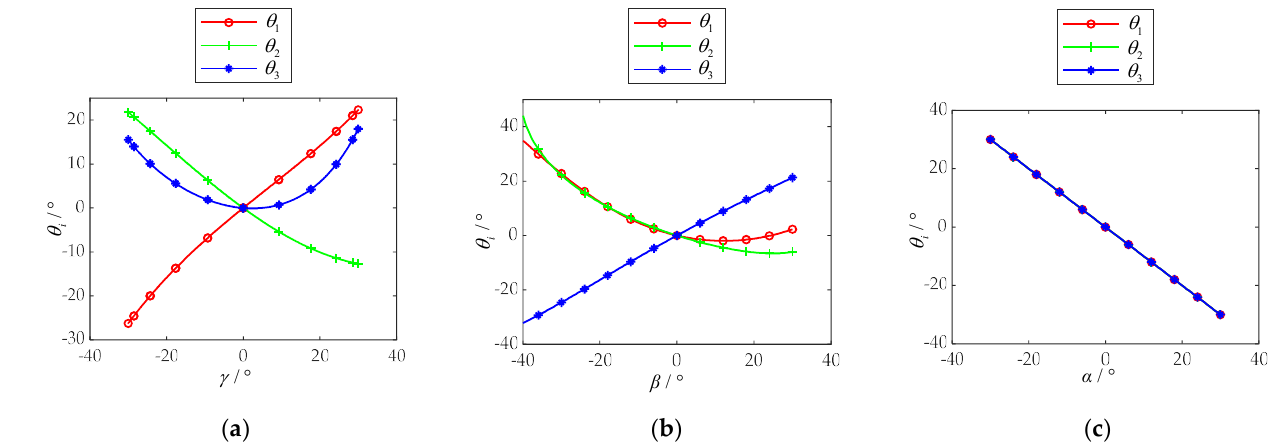
Figure 6. ( a ) Relationship between θ i and γ , when α = 0°, β = 0°; ( b ) relationship between θ i and β,